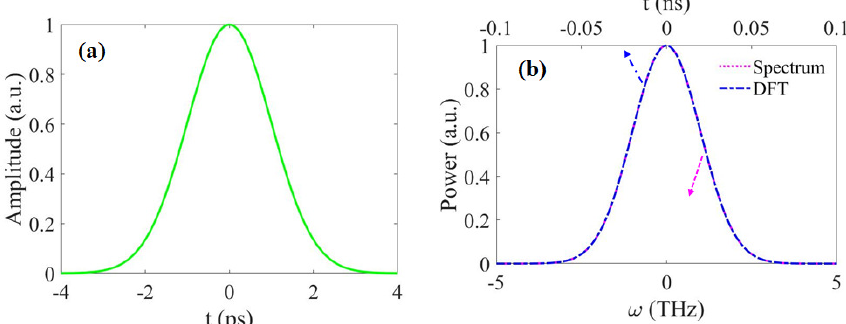
Figure 7. Time and frequency domains of the Gaussian pulse (Original pulse width = 1 ps). ( a ) Temporal profile of the Gaussian pulse; and ( b ) spectrum and dispersive Fourier transformation of the Gaussian pulse after the prism pair. The pink dotted line and blue dash-dotted line represent the spectrum and dispersive Fourier transformation of the Gaussian pulse, respectively. The light beam transfers in the prism pair with 20 m total length and 0.5 ◦ propagation angle, and the central wavelength of beam is fixed at 2.05 µ m.